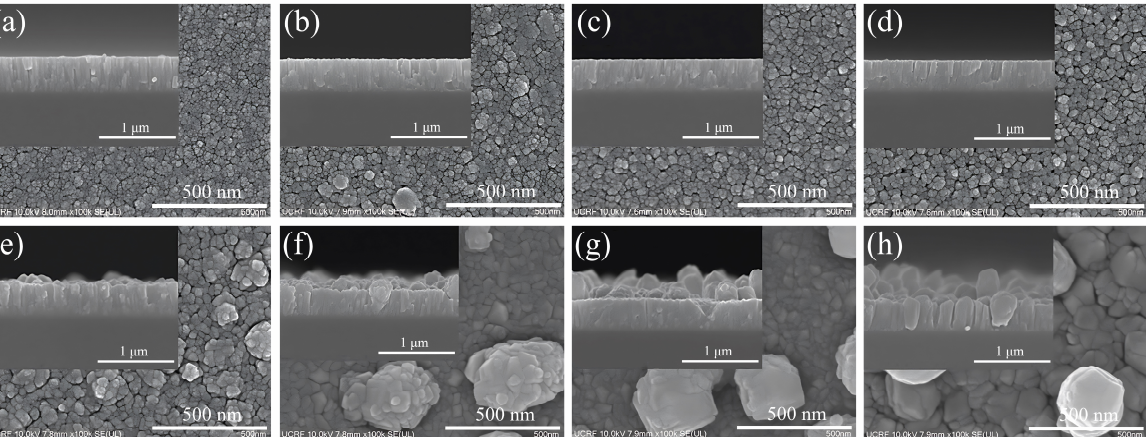
Figure 2. FE-SEM images of the surface and thickness of Cu 2 O thin films grown at various substrate temperatures: ( a ) 25 ◦ C, ( b ) 100 ◦ C, ( c ) 150 ◦ C, ( d ) 200 ◦ C, ( e ) 250 ◦ C, ( f ) 300 ◦ C, ( g ) 350 ◦ C, and ( h ) 400 ◦